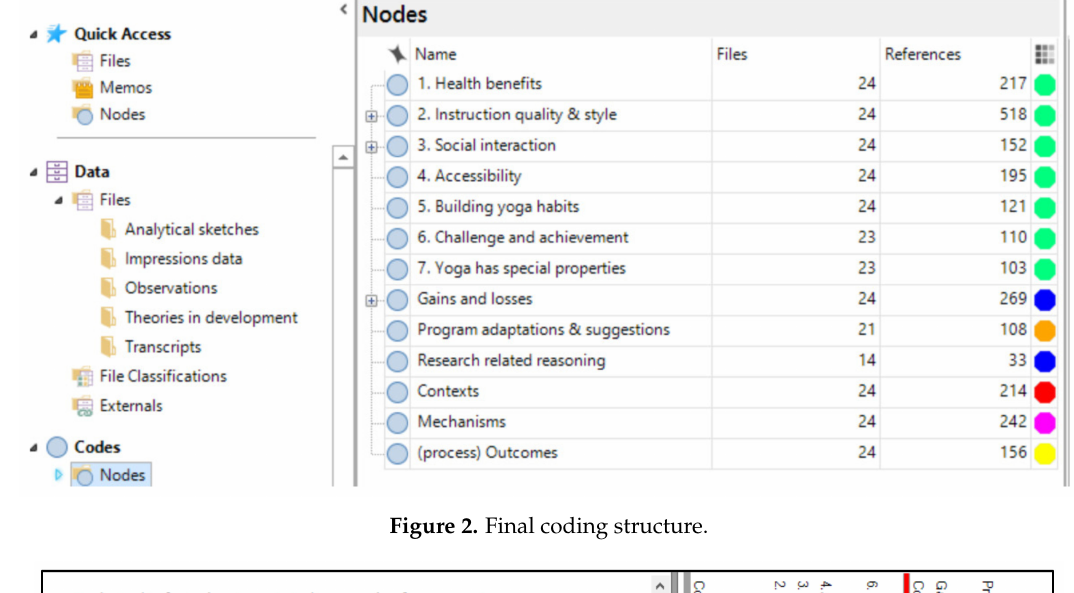
Figure 2. Final coding structure.